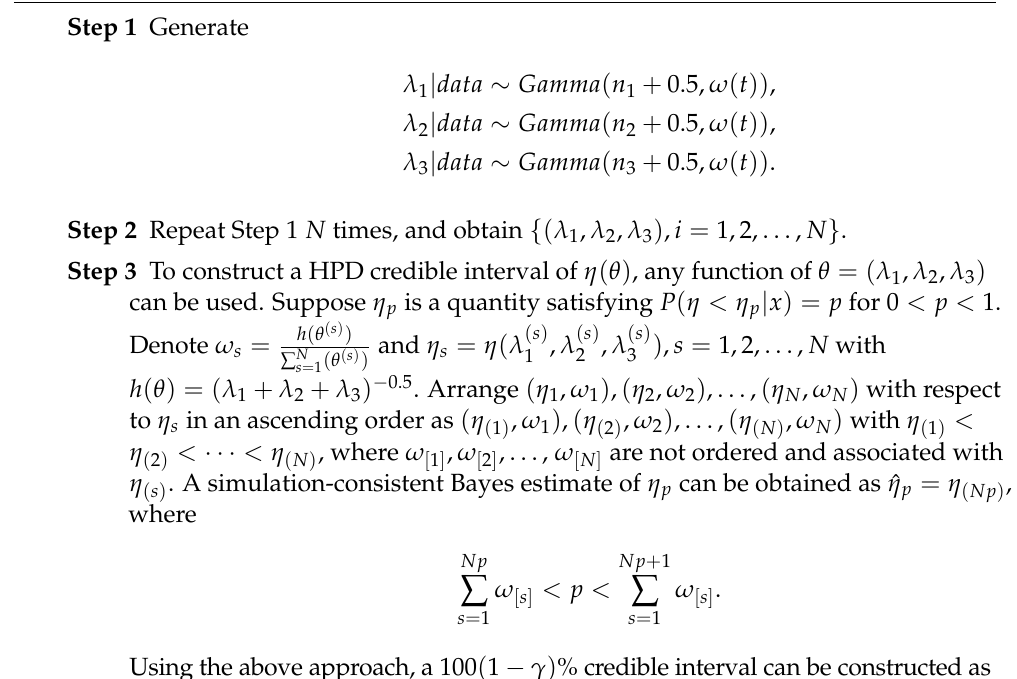
Algorithm 2: Objective Bayesian HPD credible interval